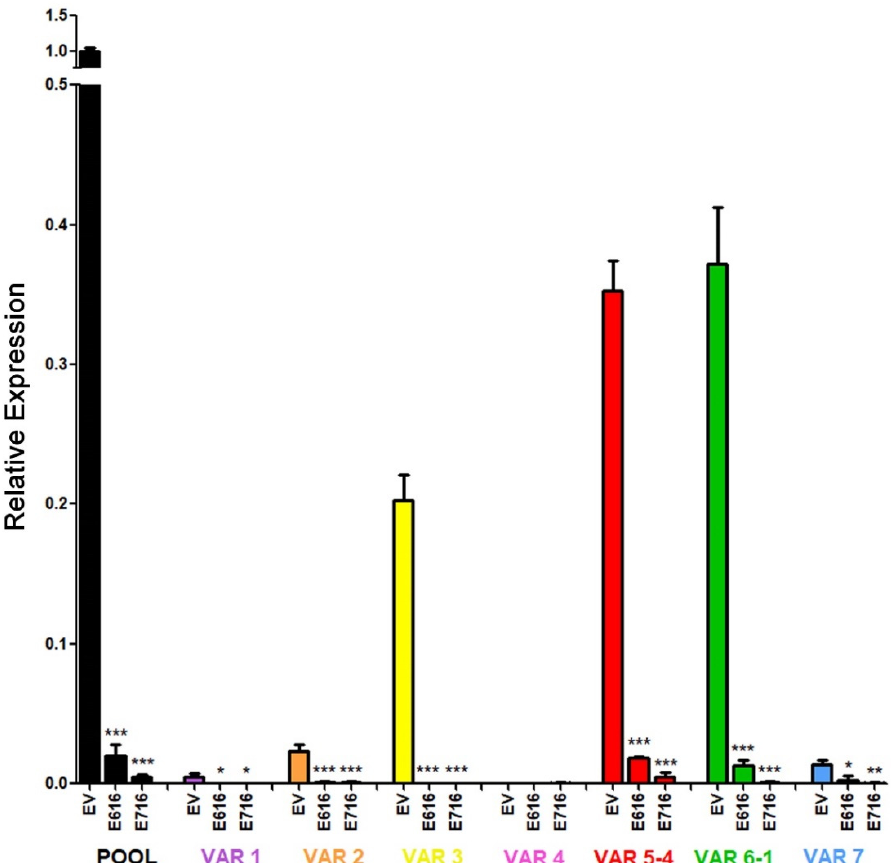
Figure 10. Effect of E616 and E716 oncoproteins on the amount of RIPOR2 transcriptional variants. Expression levels of the 1–7 transcriptional variants were assessed in C33-EV, C33-E616, and C33-E716 cells by RT-qPCR using RIPOR2 pool or specific variant primers. Statistical differences are expressed as *** p ≤ 0.0009, ** p = 0.0029, and * p ≤ 0.0166 when comparing EV vs. E616 or E716 groups.